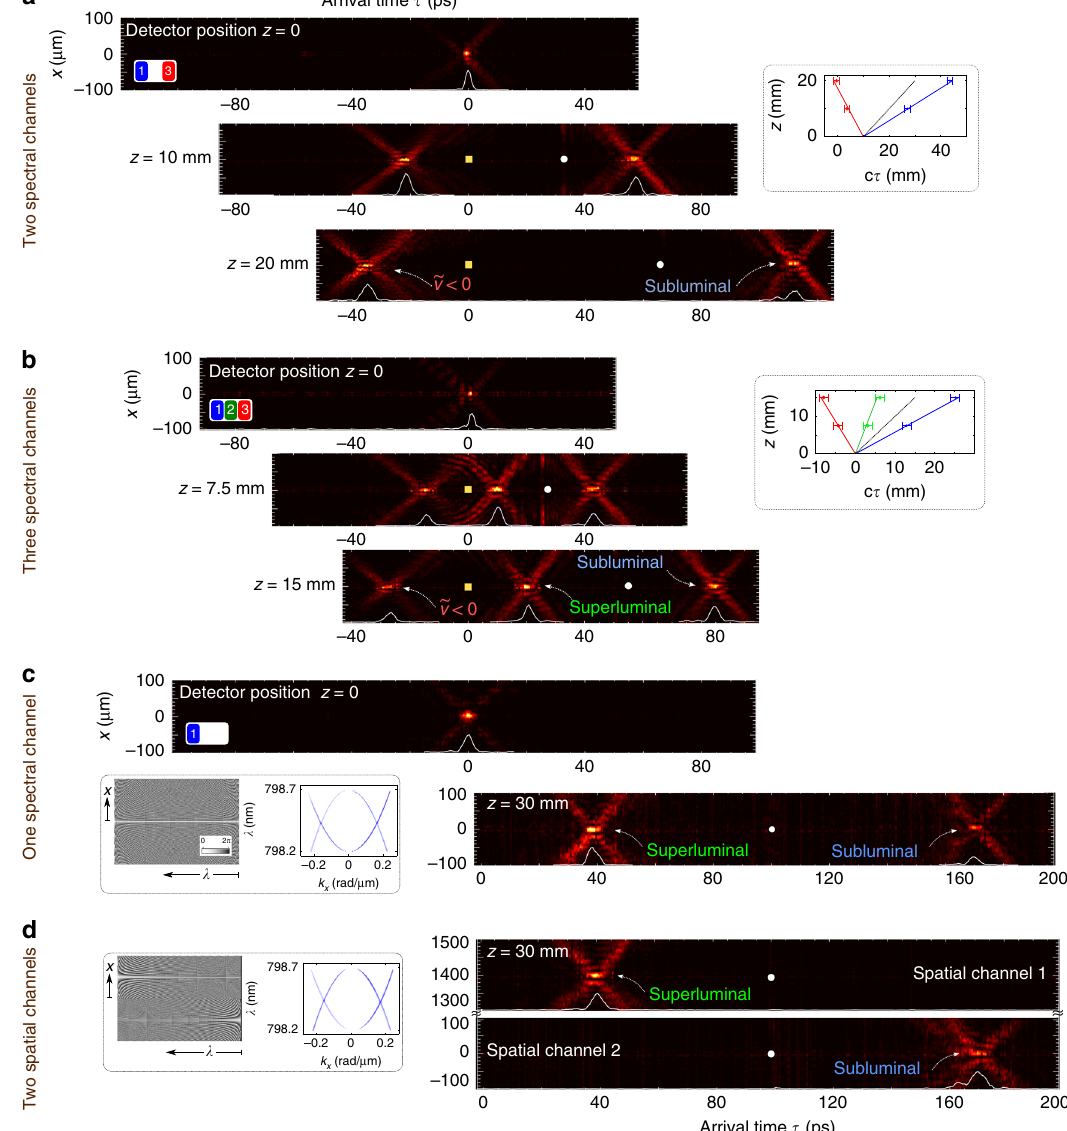
Fig. 4 Propagation of ST wave packets in different or the same spectral or spatial channels. a The panels record the arrival time of subluminal (Ch1) and negative- e v (Ch3) wave packets. The two wave packets arrive simultaneously with the detector placed at z = 0. At z = 20 mm, the subluminal wave packet arrives at τ ≈ 113 ps while the negative- e v wave packet arrives at τ ≈ − 35 ps ( earlier than the arrival time at the initial detector location of z = 0). The white circle identi fi es the arrival time of a luminal pulse, whereas the yellow square identi fi es the τ = 0 position. Inset shows the dynamics of the wave-packet centers (similarly to Fig. 3b). b Same as a but with Ch1, Ch2, and Ch3 all activated. c Two wave packets (subluminal with θ 1 = 30 ∘ and superluminal with θ 2 = 70 ∘ ) occupy the same spectral channel initially overlap when the detector is placed at z = 0, and subsequently separate at z = 30 mm. Inset shows the SLM 2D phase distribution required (interleaved distributions from Ch1 and Ch2 in Fig. 2b) and the measured overlapping spatio-temporal spectra. d Same as c but with the wave packets in two spatial channels displaced along x